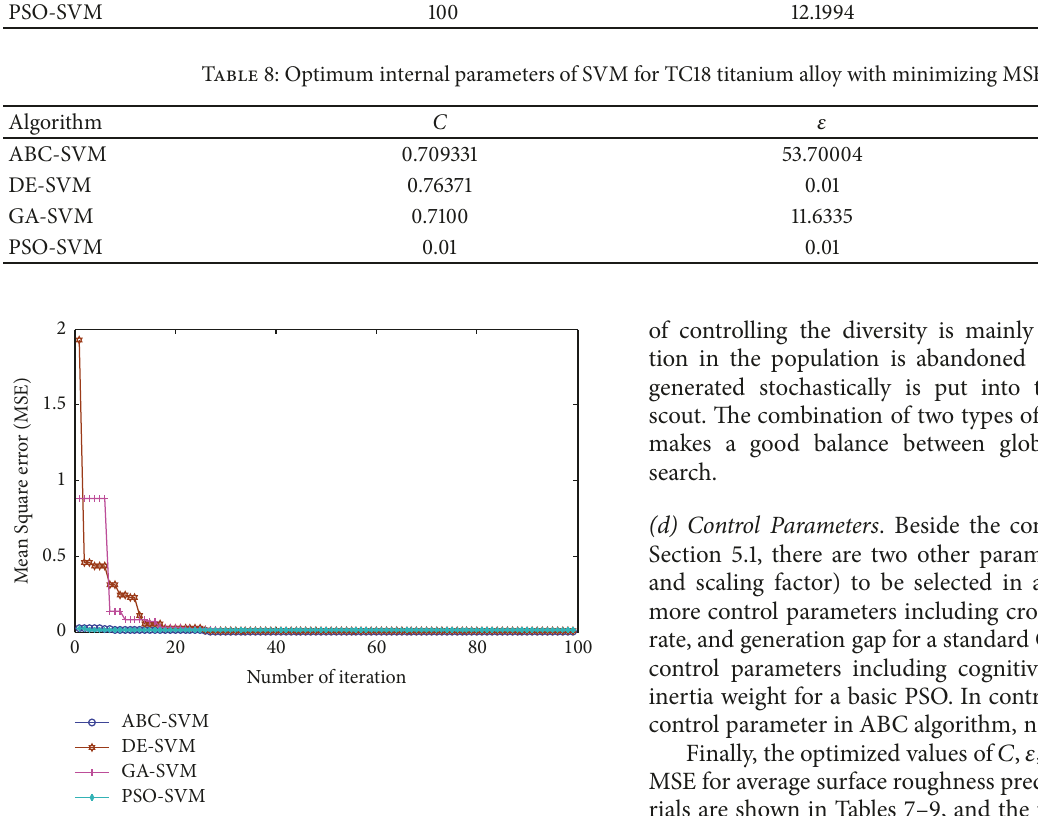
Figure 5: Marching steps for optimization of MSE for modeling Ra of Compacted Graphite